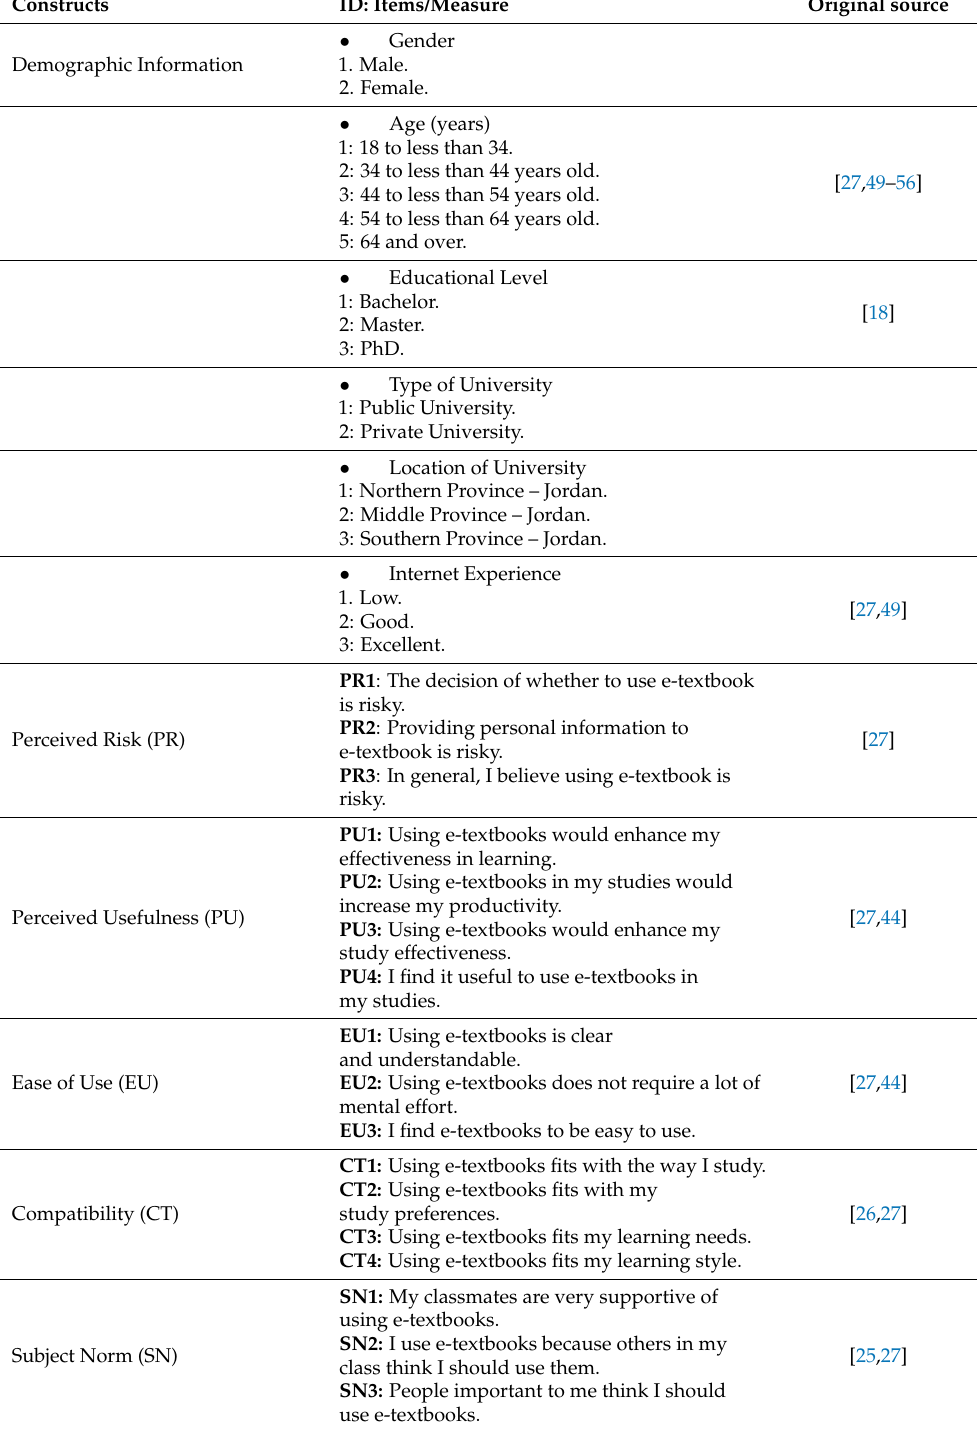
Table A1. Research Constructs, Items and